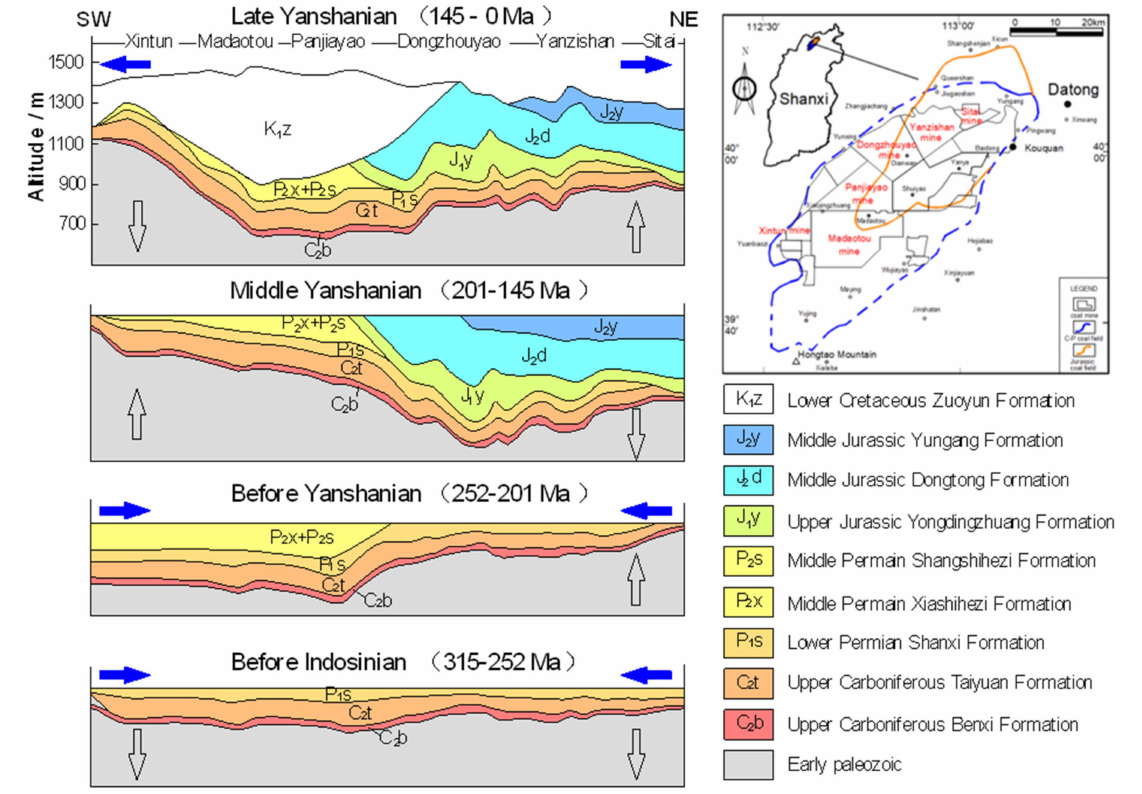
Figure 8. Structural evolution in Datong coalfield (modified from Guo et al. [98]). The blue arrow represents horizontal motion and the gray arrow represents vertical